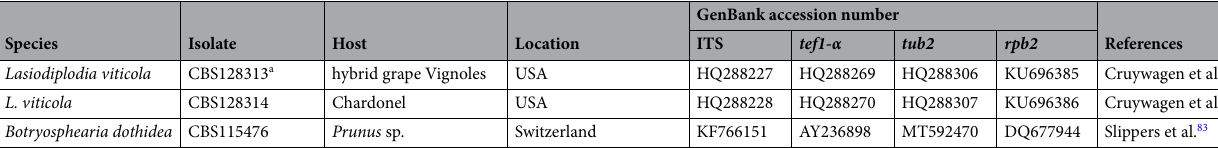
Table 2. List of GenBank accession numbers of Lasiodiplodia species and the outgroup ( Botryosphearia dothidea) used in the phylogenetic analysis. a Ex-type